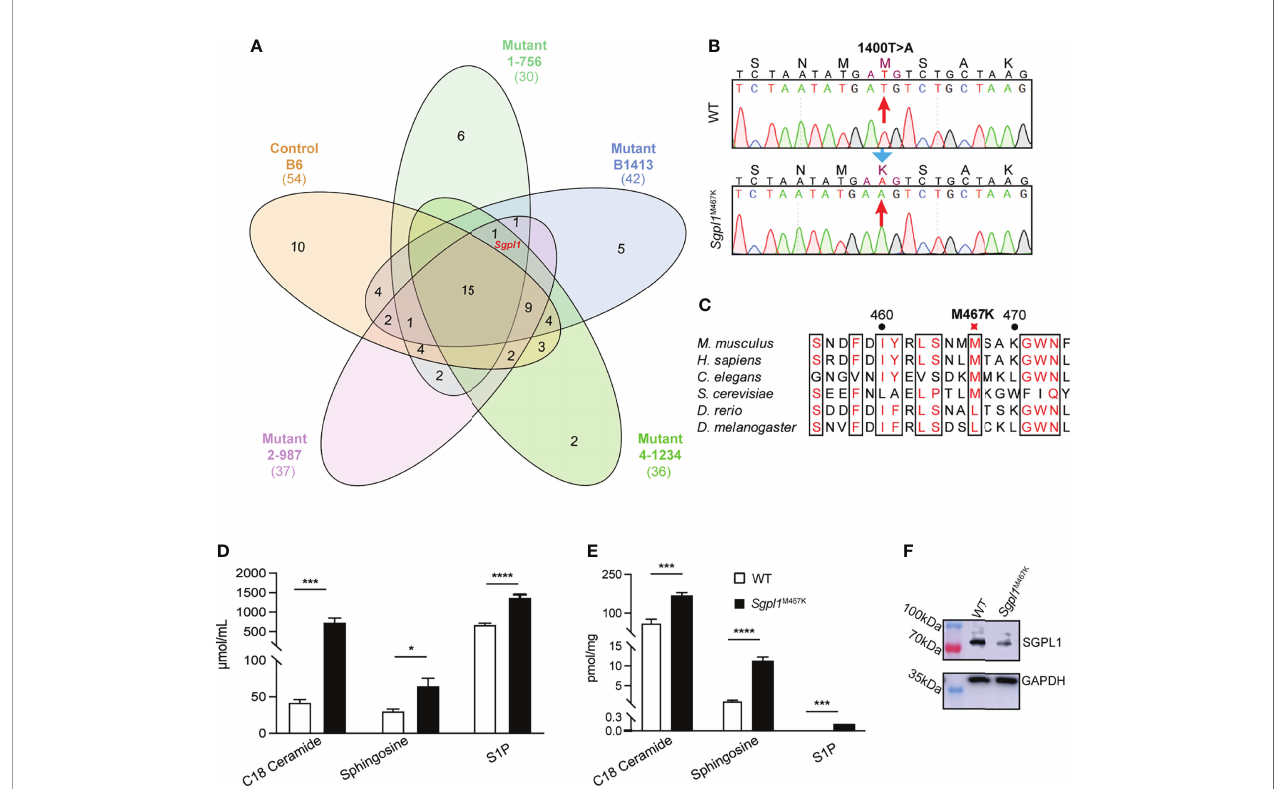
FIGURE 1 | Characterization of Sgpl1 M467K mutation. (A) Venn diagram of the shared genes with homozygous mutation between different mice. Numbers represent the number of shared genes among different mice. Red marked Sgpl1 gene is the only gene which is in all four lymphopenia mice of the same colony (1-756, B1413, 4-1234, 2-987) but absent from the B6 gene list ( Supplement Tables S1 – S5 ). (B) Mononucleotide mutation was identi fi ed and localized on 1400 (Ref. NM_009163), T changed to A. (C) Multiple protein sequence alignment of 6 Sgpl1 proteins from Mus musculus and the homologues, including Mus musculus (NP_033189.2), Homo sapiens (NP_003892.2), Caenorhabditis elegans (NP_505372.1), Drosophila melanogaster (NP_652032.1), Danio rerio (XP_005156777.1), Saccharomyces cerevisiae (NP_010580.1). (D, E) Comparison of serum (D) and cutaneous (E) C18-Ceramide, Sphingosine, S1P concentration of wild type and Sgpl1 M467K mice; fi ve wild-type and fi ve Sgpl1 M467K mice were analyzed, please note S1P concentration of wild type was under detection threshold and was de fi ned as 0 during statistic evaluation; original TIC within Supplementary Table S6 . *, p<0.05; ***, p<0.001; ****, p<0.0001; unpaired t-test, error bar represents s.e.m. (F) Western blot analysis of SGPL1 expression in kidney of wild type and Sgpl1 M467K mice; experiment repeated twice; full-length pictures were shown in Supplementary Figure S1A